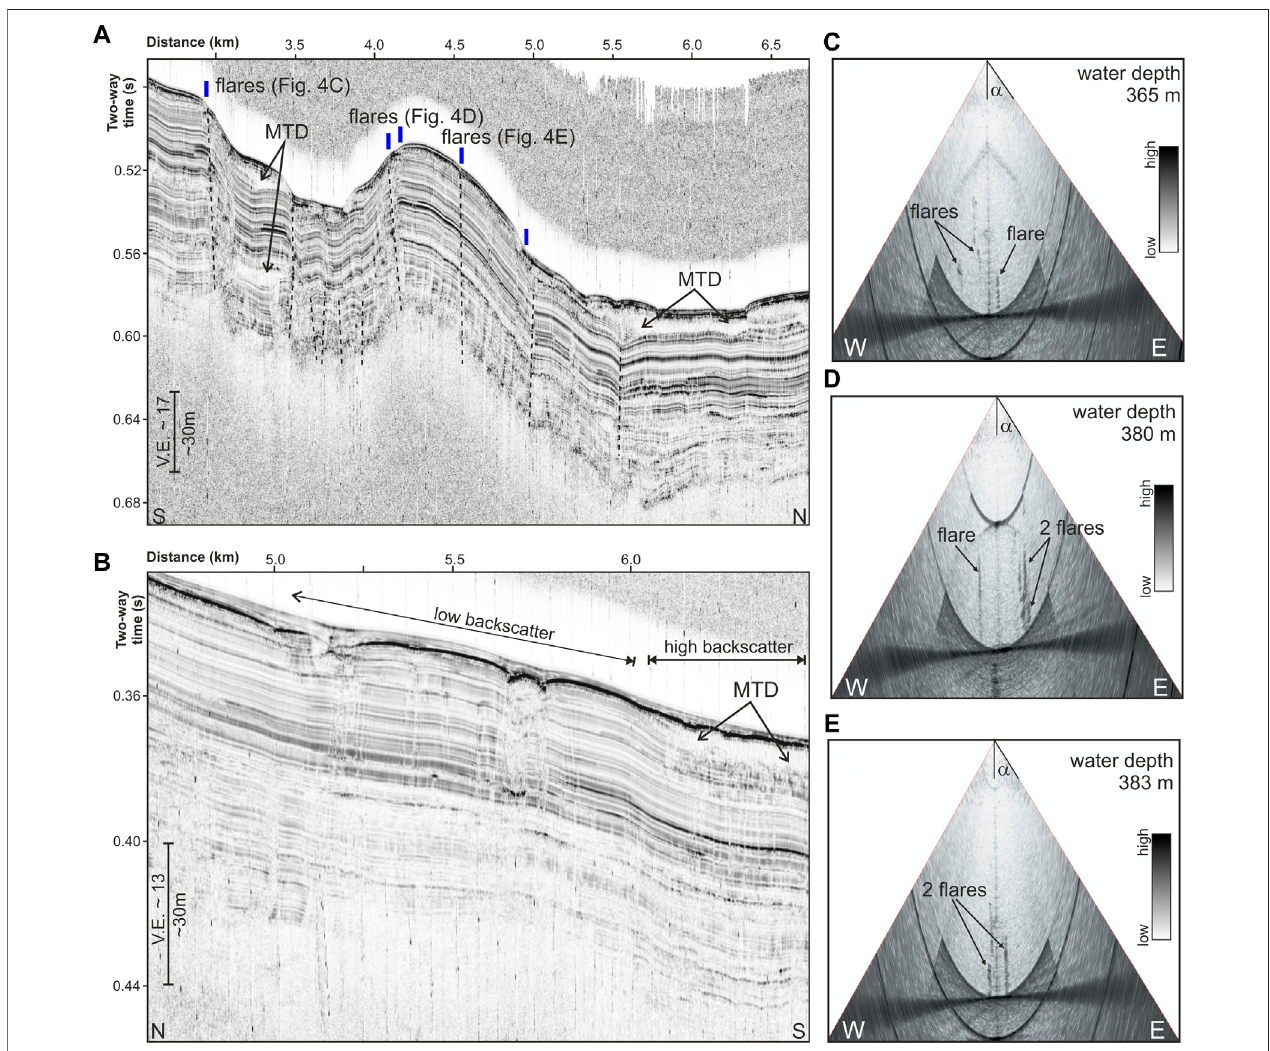
FIGURE4| Acousticsub-bottompro fi lerdataoffeaturesofthenorthern-mostN1canyon. (A) Sectionacrossthecanyonwallshowinginthesouthernhalfafaulted sedimentary package with gas seeps (location indicated by blue lines). Faults are indicated by dashed black lines. The northern half of the section is within the talweg of thecanyonwithashallowmass-transportdeposit(MTD)nearthesea fl oor.AlthoughtheMTDiscoveredby3 – 5 mthicklayered(recent)sediment,sea fl oorbackscatteris highonlywheretheMTDoccurs. Thisisseenespeciallyinthesection shownin (B) . (C – E) Examplesofgas fl aresfromtheEM710watercolumndataalongsection shown in (A) . Beam-opening angle α is 60 ° .